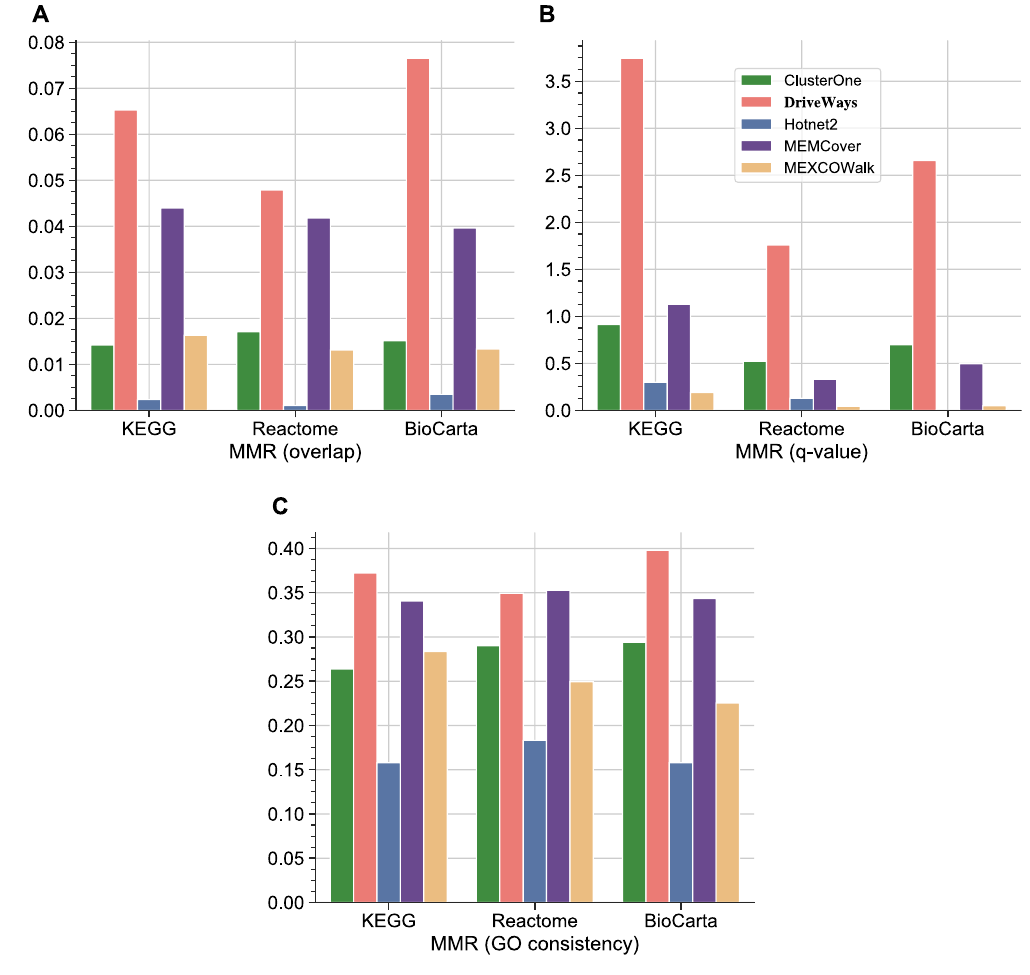
Figure 3. MMR scores of all methods calculated with three similarity metrics: ( A ) Overlap score ( B ) Hypergeometric test q-values ( C ) GO consistency. The set of reference pathways at the x-coordinate of each plot correspond to KEGG CGC , Reactome CGC , and Biocarta CGC , from left to